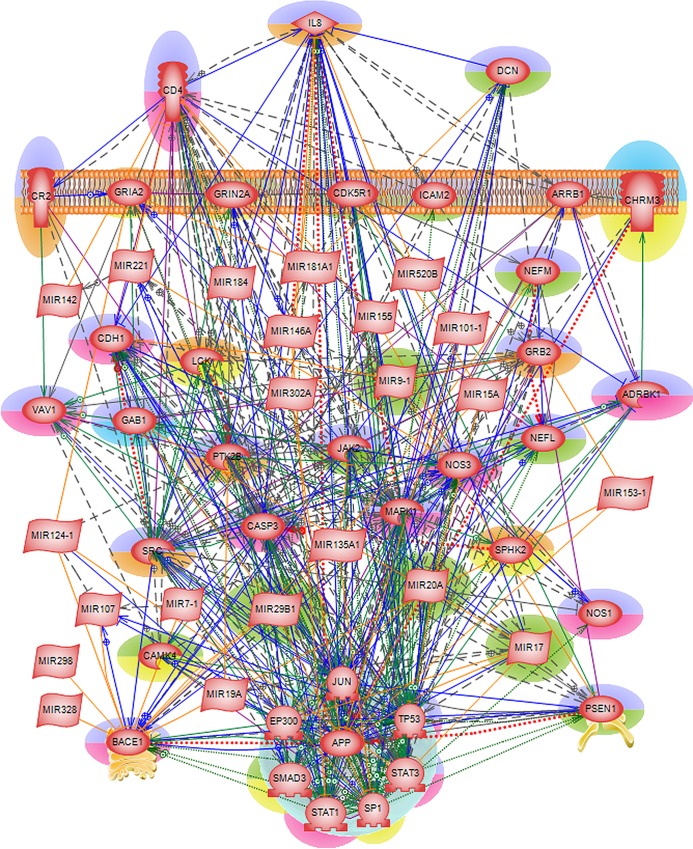
MicroRNA incorporated integrated Alzheimer’s disease mechanism.The 37 genes/proteins found in common in all 12 enriched KEGG pathways are regulated by 22 microRNAs. Genes/proteins implicated in AD pathology are highlighted in green/red and the genes/proteins of potential interest are highlighted in blue/orange (See Table 1) for details. Genes/proteins causing neuronal loss are highlighted in purple and those that help in neuronal survival are in yellow.